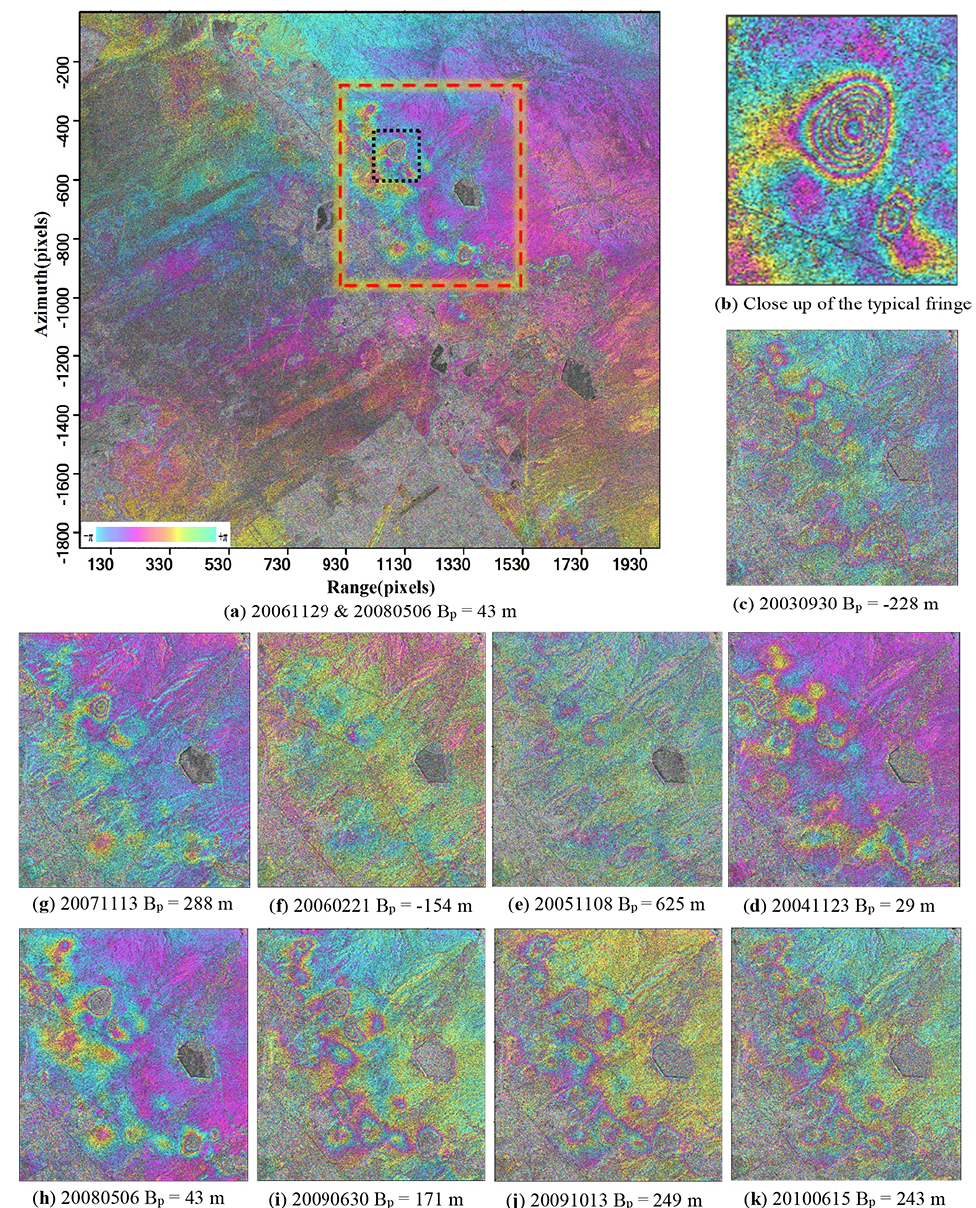
Figure 6. ( a ) The representative interferogram generated from the data pair (29 November 2006 and 6 May 2008); ( b ) Close ‐ up view of a typical fringe map, where the location is indicated by the black dashed lines in Figure 6a. Figure from ( c ) to ( k ) correspond to the main deformation area, which is highlighted in a red dashed line in ( a ), and they show the interferometric phase change in different time periods. The image in 29 November 2006 is the common master image.